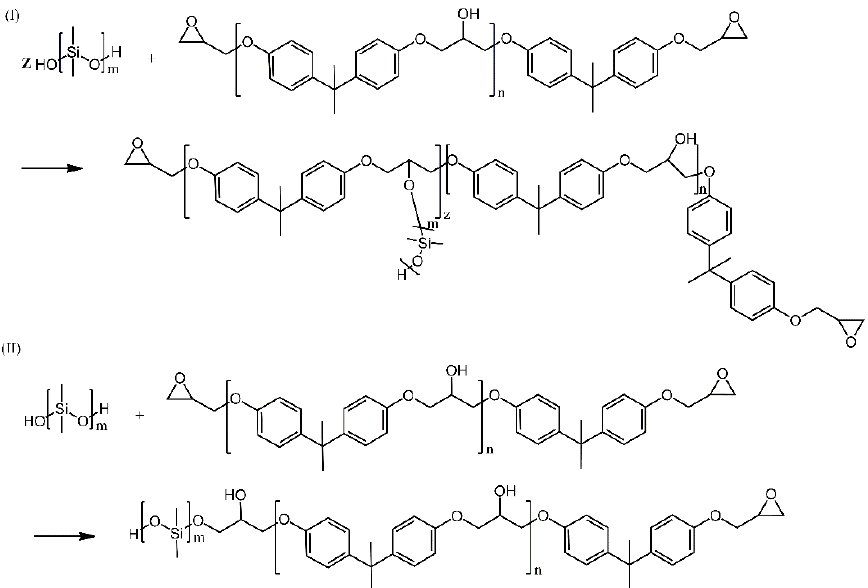
Figure 12. ( I ): dehydration, ( II ): etherification of hydroxyl groups between silicon oil and epoxy resin. Based on Ref. [30].